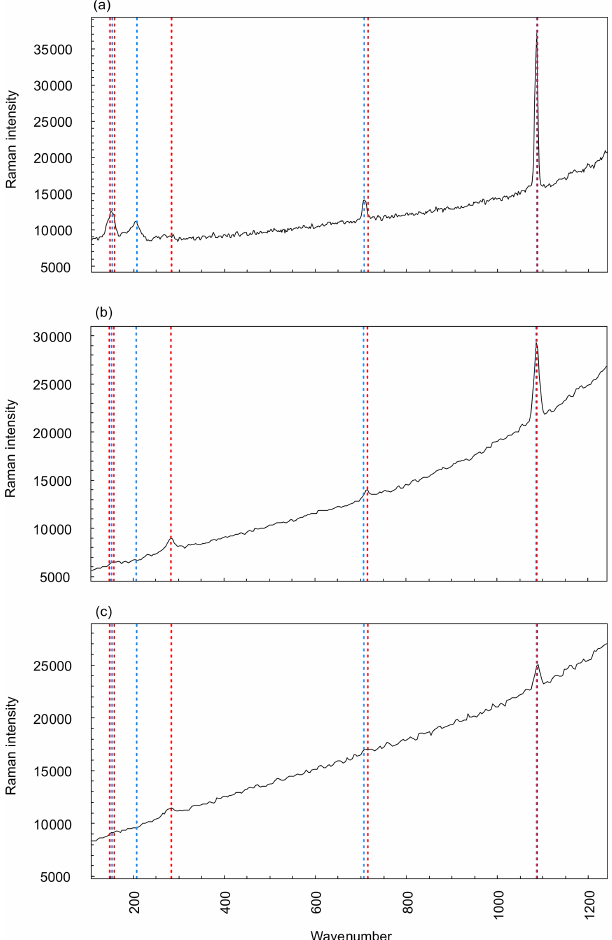
Figure 3. Raman spectroscopy graphs comparing three measured specimens, G. bathoniana (a) , G. balakhmatovae (b) , and G. to- jeiraensis (c) , against pre-collected data for aragonite (red dashed) and calcite (blue dashed). Peaks with vertical lines show direct com- parisons to calculate the more applicable mineralogy, as denoted by the similarity between peaks and reference modes. Aragonite and calcite present very similar Raman graphs, with the primary differ- ence being the peaks at lower wavenumbers. Higher wavenumbers are differentiated by more precise detail. Reference mode data for aragonite and calcite taken from Urmos et al.